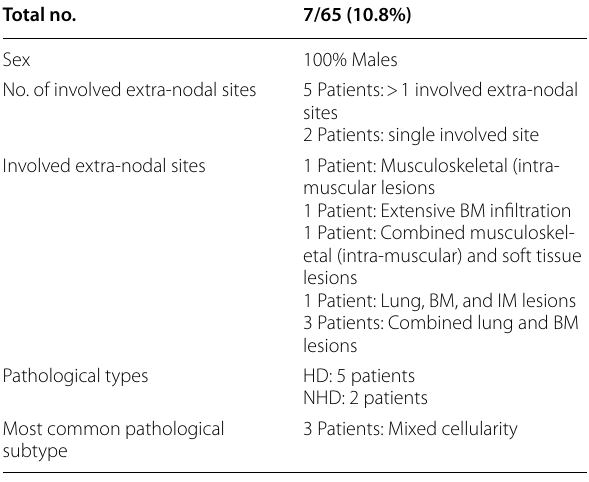
Table 6 Summary of DS‑based interim ‑ve patients with disease relapse during follow‑up Total no.